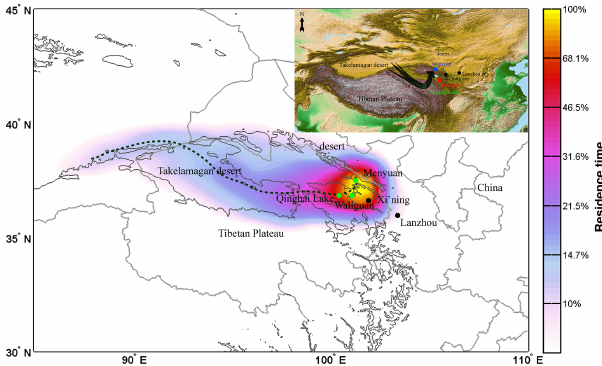
Figure 1. FLEXPART retroplume simulations during 10 September–15 October. Topographical map showing the sampling location and surrounding regions in the Tibetan Plateau. Xining is the capital city of Qinghai province. Menyuan represents sampling site. The black line shows the major back trajectories of air mass during 10 September–15 October 2013 based on the spatial distribution of the air mass. The main air mass mainly passed through rural areas, grasslands, and